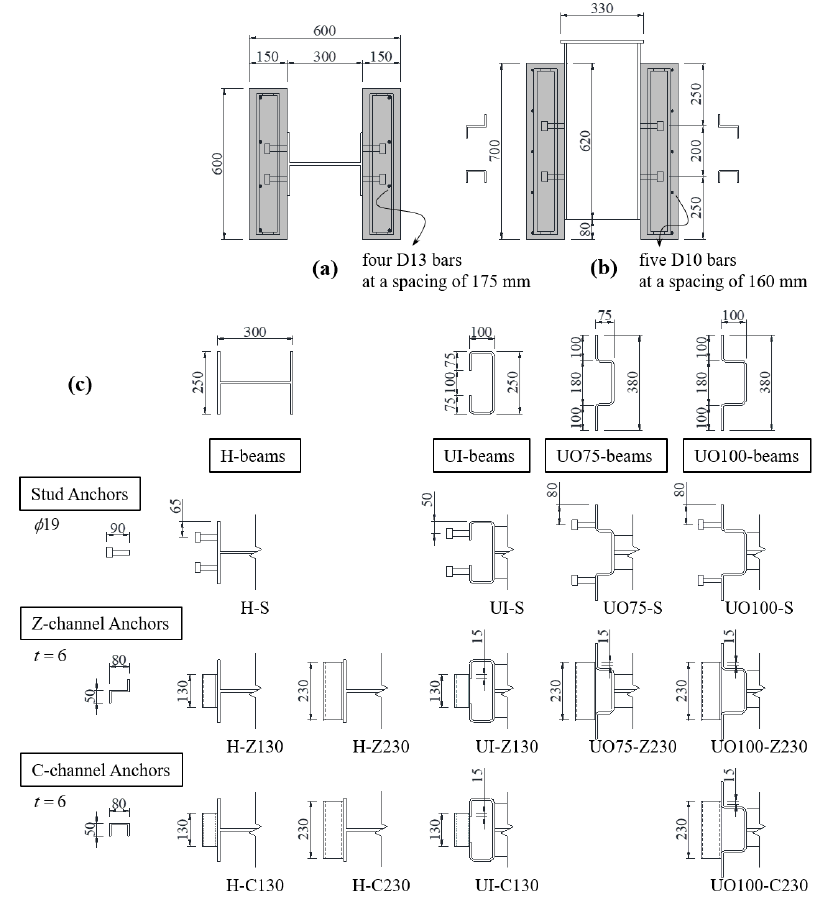
Figure 2. Test specimens (units in mm): ( a ) typical section; ( b ) typical elevation; ( c ) details of the steel beam and steel anchor.